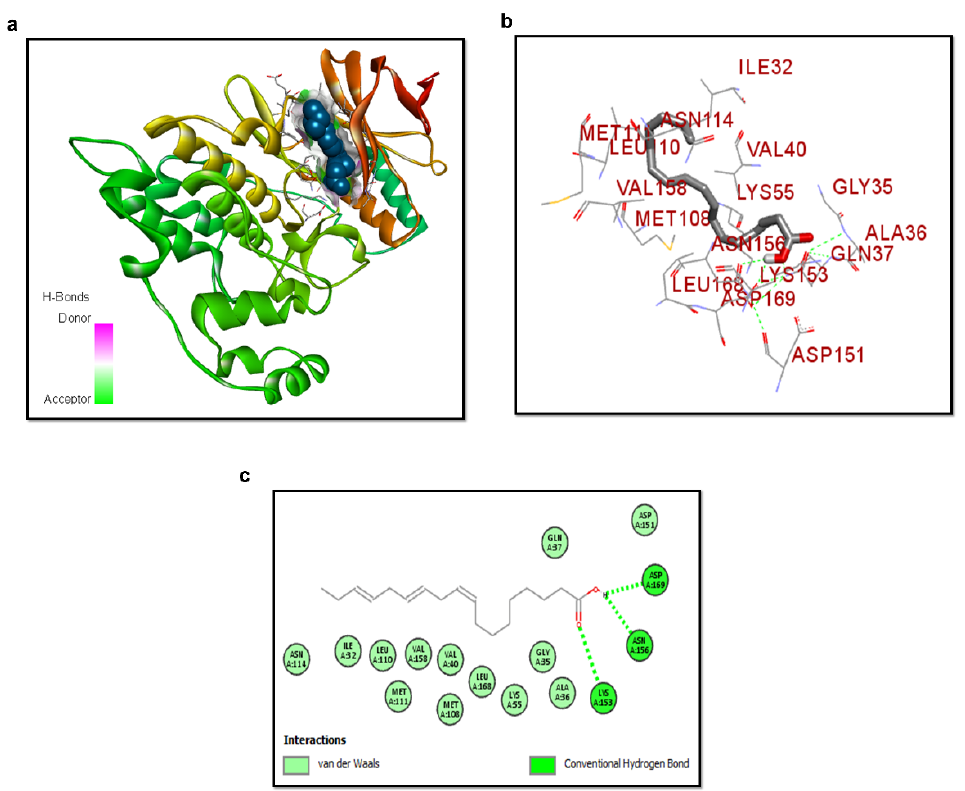
Figure 3. Structure of p-JNK/ALA complex. ( a ) ALA docked in the binding site of JNK. α -helices and β -strands in the catalytic domain are shown in reddish and yellow, respectively. ( b ) shows the silver color ligand ALA and interactive residues. ( c ) Binding mode interaction of ALA with the active site residues. The green dotted lines are the conventional hydrogen bond of ASP169, ASN156, and LYS153 active site residues with ALA.